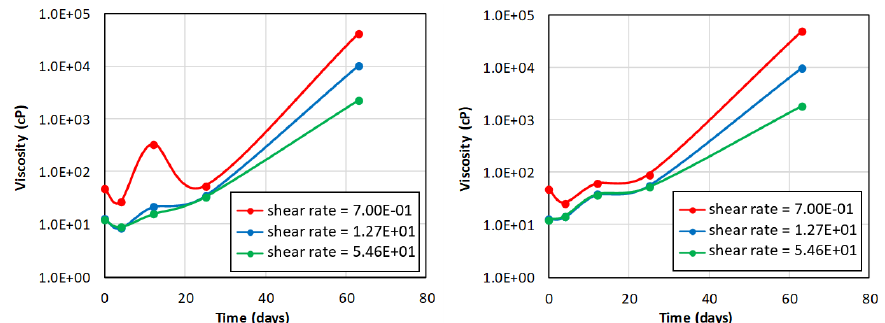
Figure 6. Aging of solutions in Series 23 collected during injection of nanomaterial/polymer solution in a core at 80 °C: Samples collected early ( left ) and collected at the end of the injection ( right ).